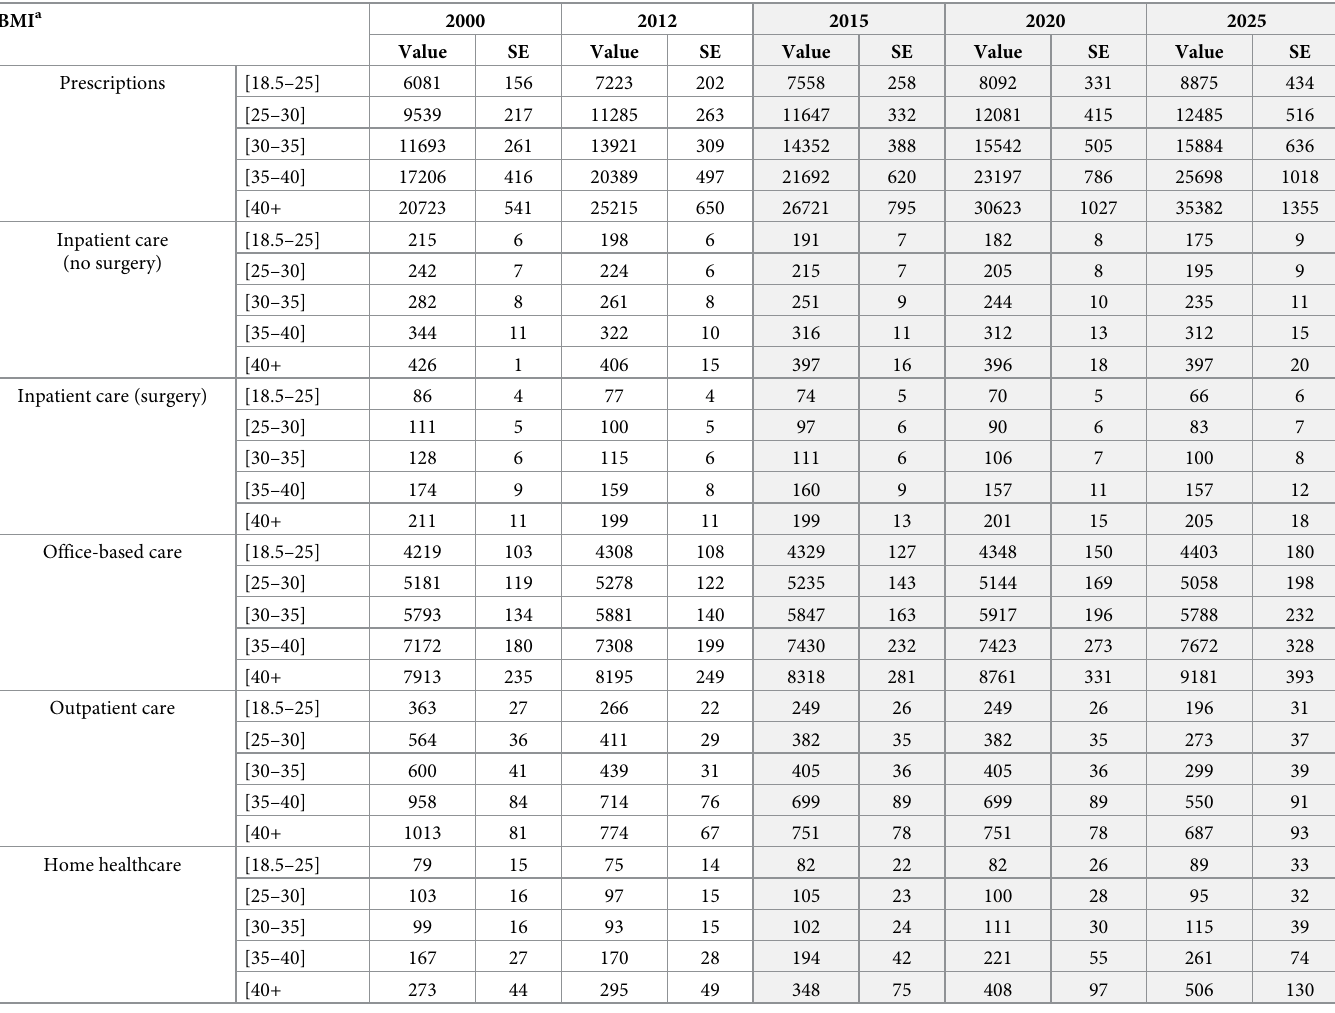
Table 2. Healthcare service use and (standard error) per 1000 persons by year, category of service and BMI; US population 2000–2025. BMI a